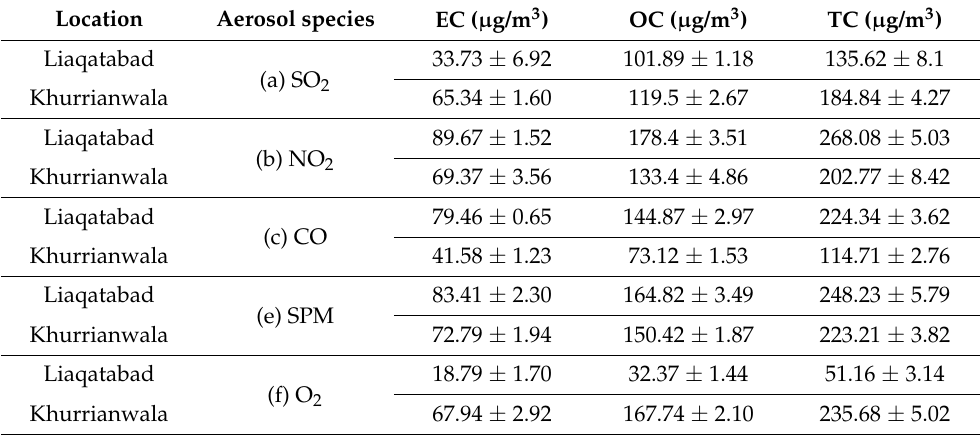
Table 7. Carbonaceous species in air pollutant samples during the summer season.